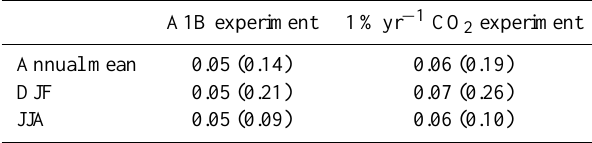
Table 1. Globally averaged differences in annual mean, DJF and JJA surface air temperature (SAT) trends (in K per decade) between GROUP1 and GROUP2 models in the A1B and 1%yr − 1 CO 2 ex- periments. Numbers in parentheses are the trend differences aver- aged over the Arctic region (60 ◦ N–90 ◦